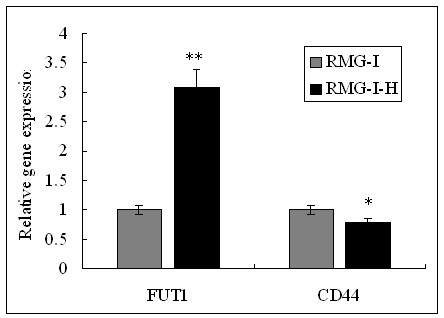
The mRNA expression of CD44 and α1, 2-FT in RMG-I and RMG-I-H cells were tested by quantitative Real-Time RT-PCR. The mRNA level of α1, 2-FT was significantly increased, but the mRNA level of CD44 was almost the same in RMG-1-hFUT cells and RMG-1 cells. (**P < 0.01, * P > 0.05).